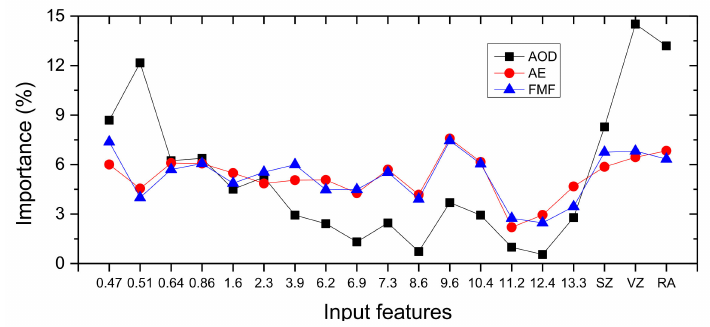
Figure 4. Aerosol retrieval importance of Himawari-8/AHI input features. The numbers on the horizontal axis are spectral bands in µ m. SZ, VZ and RA are solar zenith angle, viewing zenith angle and relative azimuth angle respectively.